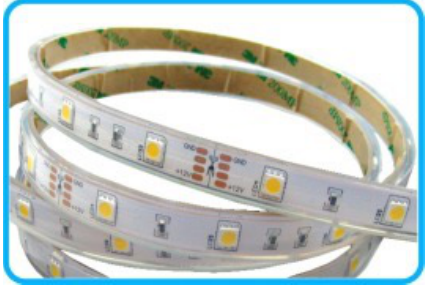
Figure 10: Graph, representing the building sectors as vertices and corridors between sectors as edges.